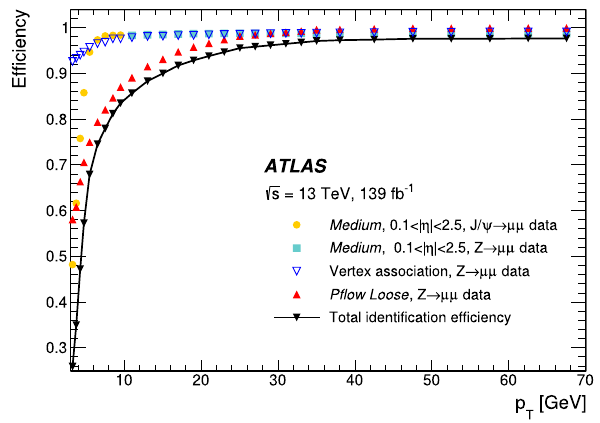
Fig. 21 Overall reconstruction and identification efficiency measured in data with Z → μμ and J /ψ → μμ decays for prompt muons with p T > 3GeV.Thetotalidentificationefficiencyforsatisfyingsimultane- ously the Medium , PflowLoose isolation and vertex association criteria (black line) is shown together with its separate components (coloured markers)